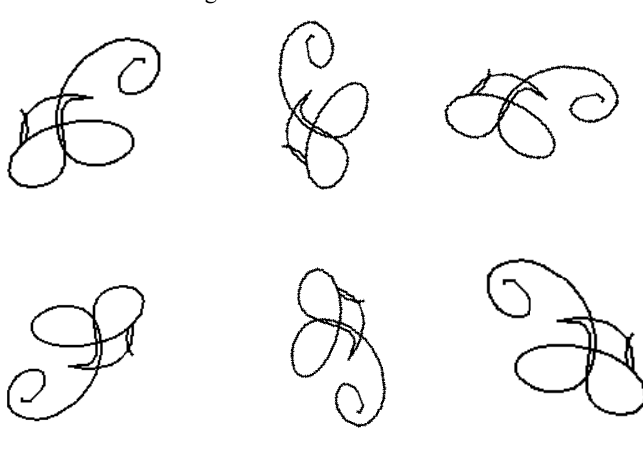
Figure 7. Sample Augmentation of